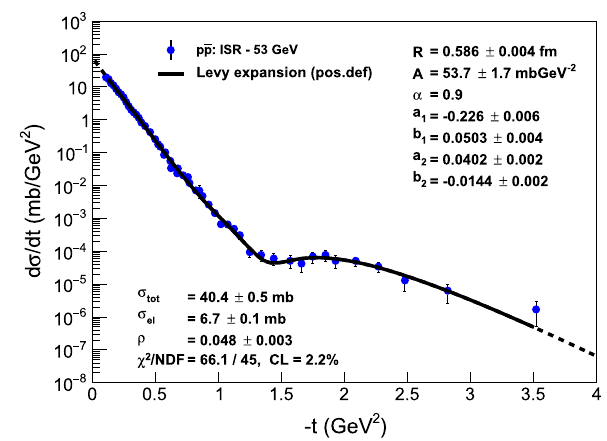
Fig. 24 Fourth-order Lévy expansion fits of the differential cross- section data from Ref. [45] on pp elastic scattering at GeV